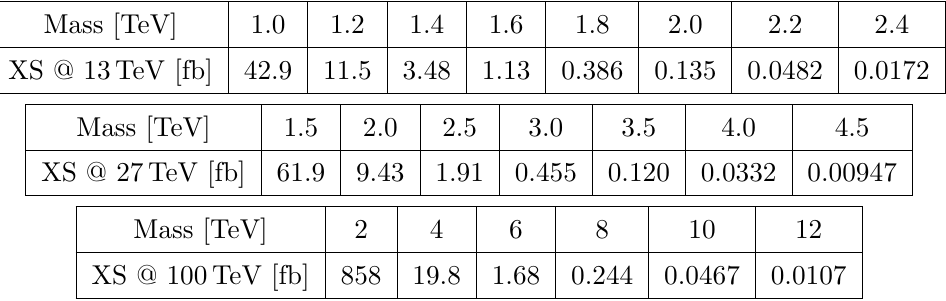
Table 8. The NNLO cross sections for QCD pair production of the top partners at various collision energies of pp